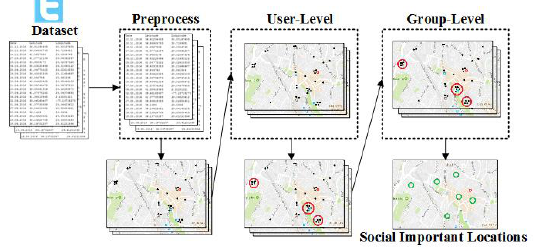
Figure 2. Steps of SS-ILM